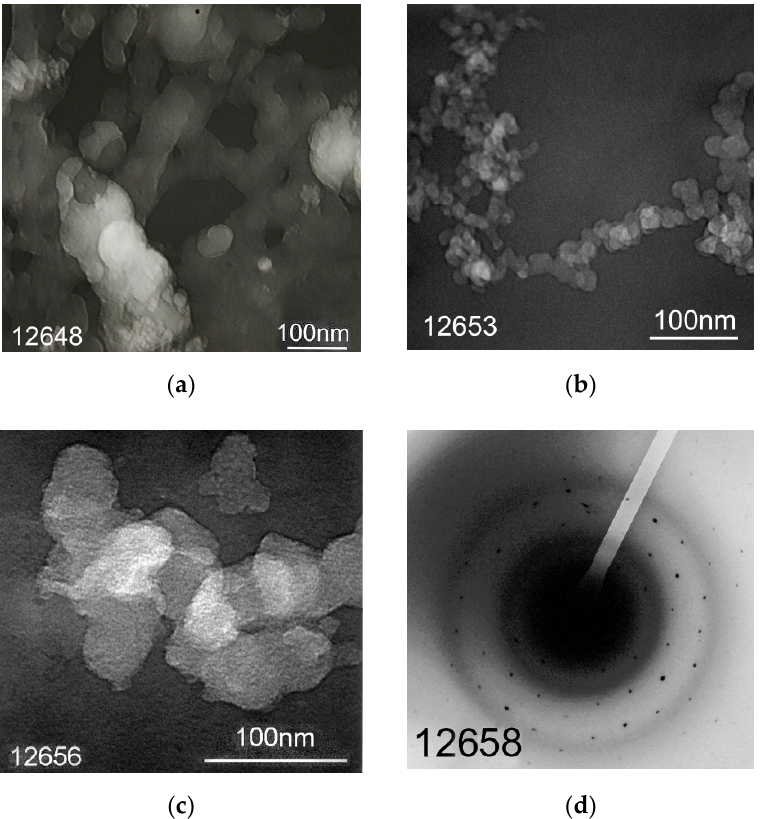
Figure 6. Morphology of rice husk hydrolytic lignin presented by different forms particles: ( a ) fibers; ( b ) dendritic formations; ( c ) rounded particles; ( d ) microdiffraction pattern.